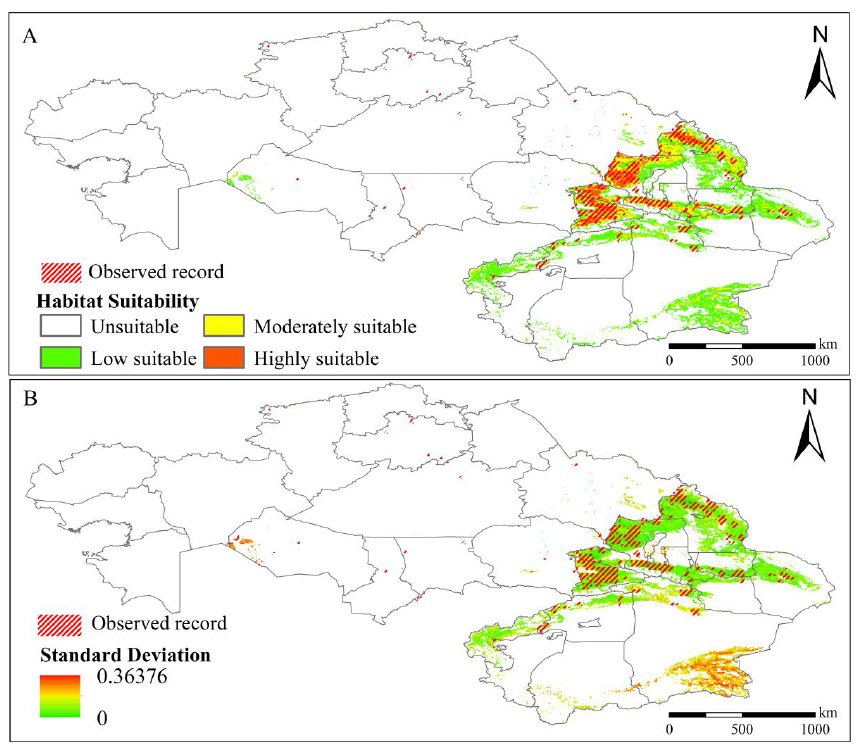
Figure 3. Prediction of potential habitats for typical locusts under current conditions. ( A ) Predicted probability of occurrence. ( B ) Standard deviation in 10 replicate tests.